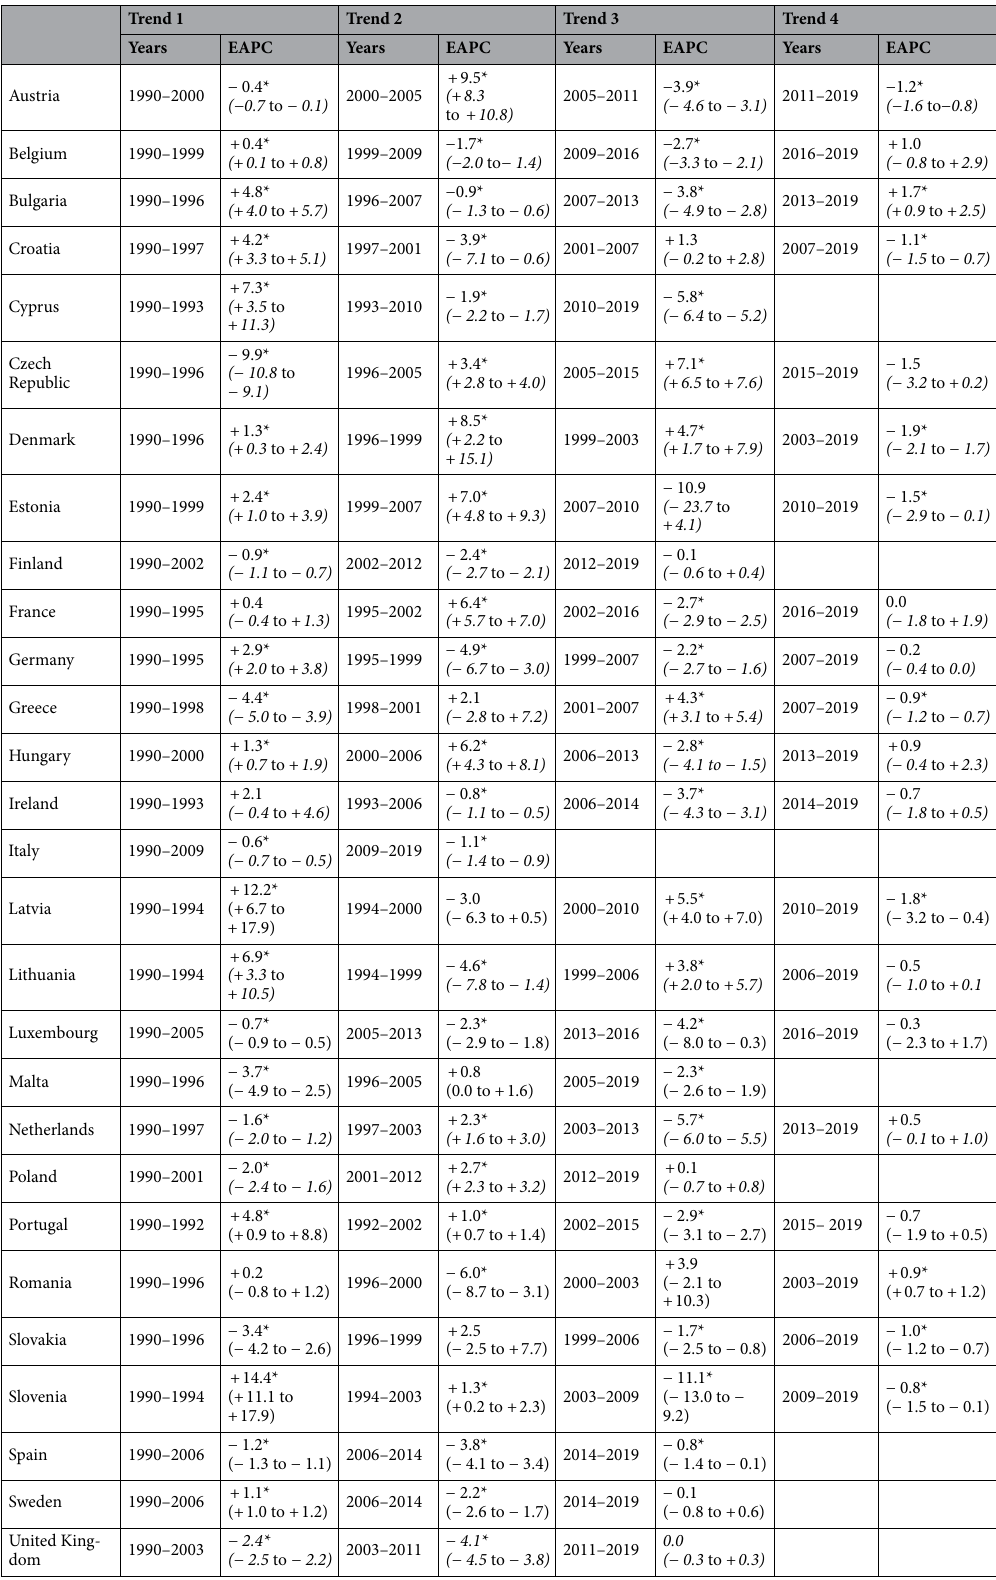
Table 1. Joinpoint analysis for age-standardised mortality rates (ASMRs) per 100,000 population resulting directly from type 2 diabetes mellitus (T2DM) in males. Italic values indicates 95% confidence intervals. EAPC indicates estimated annual percentage change with 95% confidence intervals in brackets. *Significantly different from 0 (P <